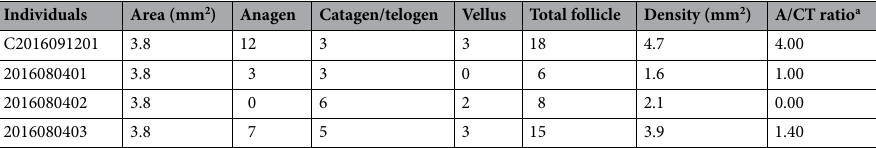
Table 2. Estimation of follicular density, stages, and anagen to catagen/telogen ratio for the skin biopsy of Formosan macaques with symmetrical alopecia in comparison with individuals with normal hair appearance. a A/CT ratio denotes anagen to catagen/telogen